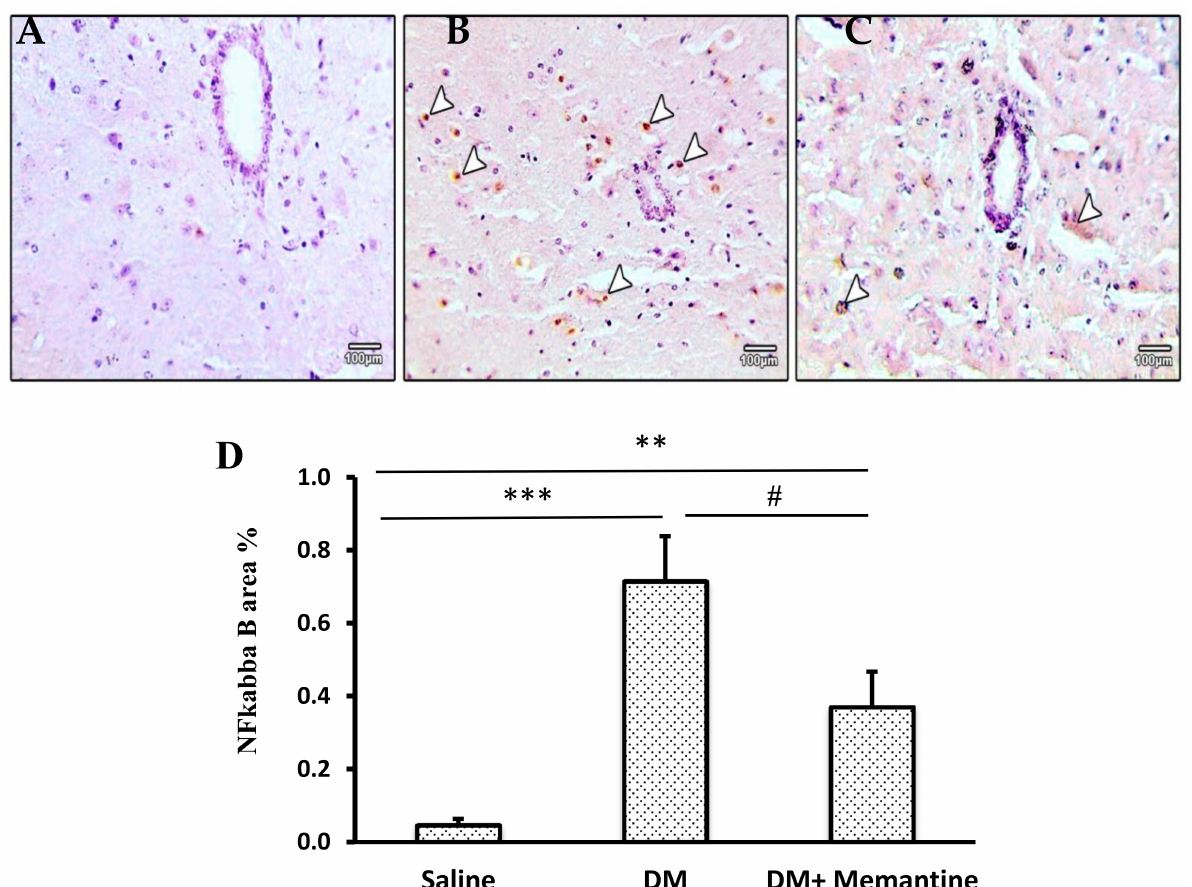
Figure 8. Microscopic pictures of NF-kB immunostained sections from the spinal cords. Images show cross sections with: ( A ) very mild staining in the saline group, ( B ) strong positive nuclear expression in neural cells (arrow heads) from the diabetic group, and ( C ) decreased positive nuclear expression in neural cells (arrow heads) from the DM+memantine group. Immunohistochemistry counterstained with Mayer’s hematoxylin. × 100; bar 100 µ m. ( D ) Data are mean staining area ± SDM. DM: diabetes mellitus, SDM: standard deviation of the mean, and NF-kB: nuclear factor-kappa B. ** p < 0.01, and *** p < 0.001 versus the saline group; # p < 0.05 versus the DM